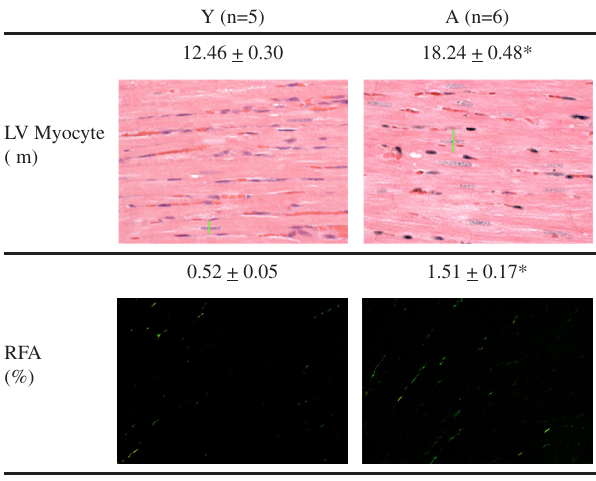
Table 1 - Baroreflex sensitivity (alpha index), pulse interval variability (PIV) and systolic blood pressure variability (SBPV) in time and frequency domains (low frequency, LF and high frequency, HF)